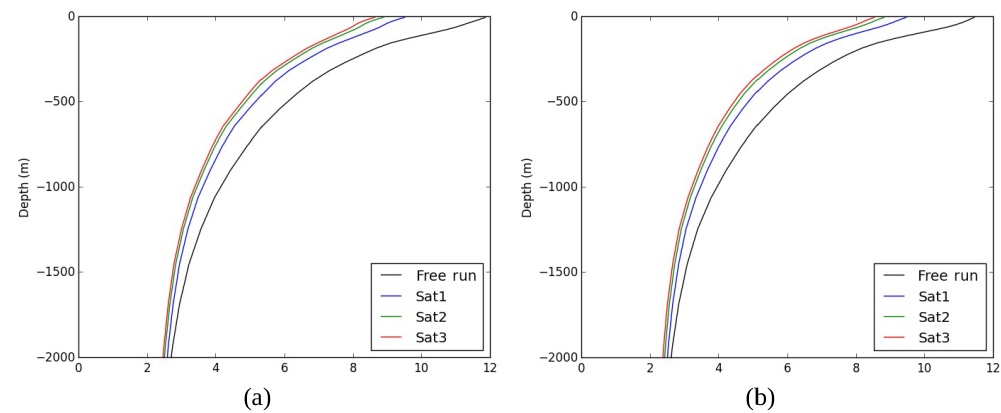
Figure 13. Global 7-day forecast RMSE of U (a) and V (b) profiles in cms − 1 for FR (black), Sat1 (blue), Sat2 (green) and Sat3 (red).